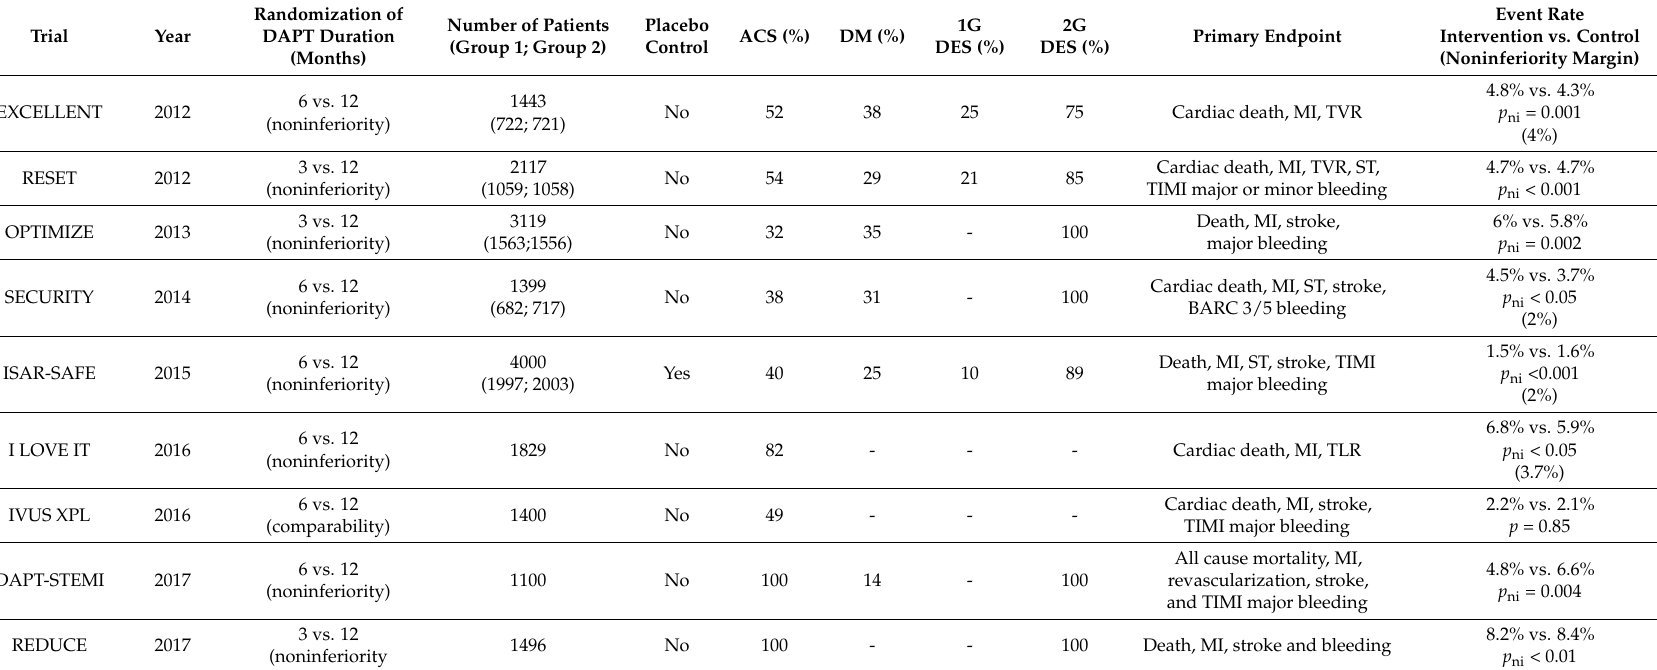
Table 3. Comparative features of randomized controlled trials (RCTs) for short DAPT (S-DAPT) vs. standard